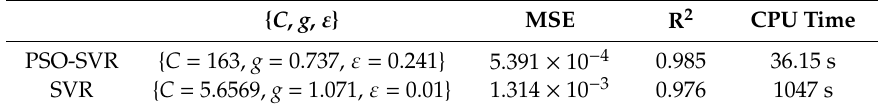
Table 6. Comparison of evaluation parameters between particle swarm optimization-support vector regression (PSO-SVR) and support vector regression